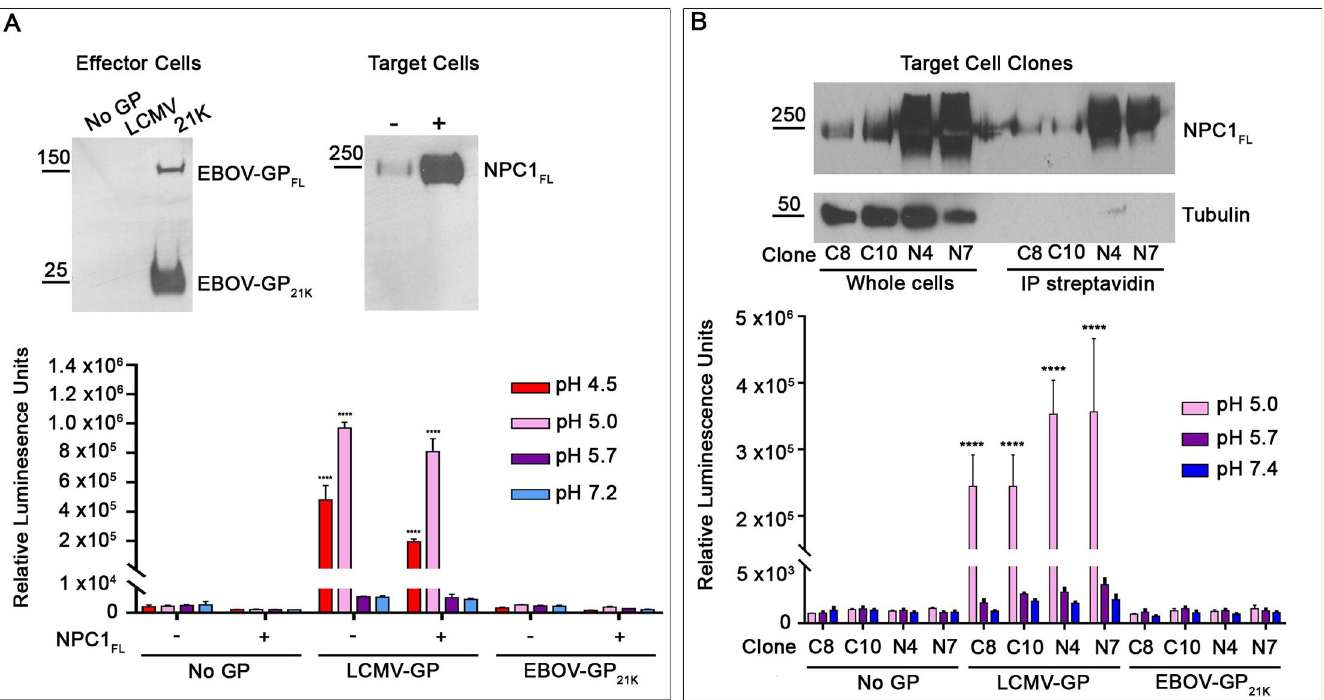
Fig 5. Cells expressing full length NPC1 at the cell surface do not support detectable fusion with cells expressing Ebola GP cl . (A) Transient NPC1 expression: Effector HEK293T/17 cells were transfected to express the indicated (or No) GP and DSP 1-7 . Target cells were transfected to express (+) or not (-) full-length NPC1 and DSP 8-11 . Effector and target cells were analyzed, respectively, for surface exposed EBOV-GP1 and NPC1 following surface biotinylation, avidin precipitation and blotting for EBOV GP or NPC1. Cocultures of effector and target cells were then treated for CCF and analyzed as in Fig 1A . (B) Stable NPC1 expression: (Top) Selected clones (C, control or N, expressing full-length NPC1) were analyzed for NPC1 in whole cell lysates by western blots (left set) and for cell surface exposed NPC1 as in A . Blotting for beta-tubulin was used as a control for protein loading (left set) and cell intactness (right set). Parallel sets of cells depicted in the gels were then used as targets in CCF experiments with effector cells expressing the indicated (or No) GP. Cocultured effector and target cells were then processed as in the graph shown in panel A . Results represent mean +/- SD of triplicate samples from one of two experiments with similar results. Statistical analyses are based on two-way ANOVA tests; each sample was compared to the respective No GP sample ���� p <